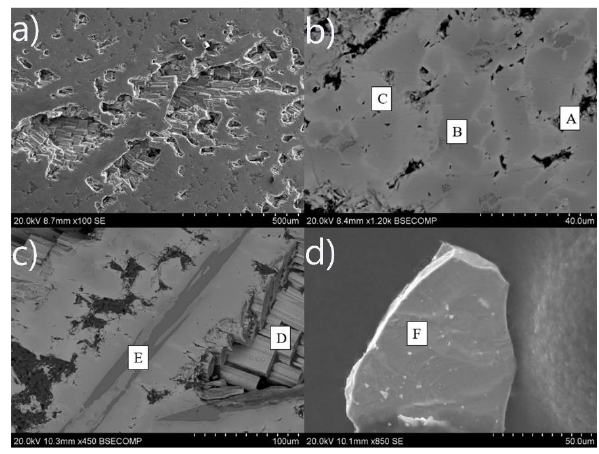
Figure 2. Scanning electron microscope (SEM) micrographs and energy dispersive X-ray spectroscopy (EDS) analysis of Al – Pd – Fe samples prepared by SPS. ( a – c ) reveal the as-cast state and ( d ) the fragment of measured single crystal. (a) and (d) were taken with secondary electron (SE), ( b ) and ( c ) were taken with back-scattered electron (BSE). EDS analysis was performed on different sites of the denoted regions A – F and results are listed in Table 1. Table 1. The chemical compositions of a piece of educts and a fragment of single crystal from the spark plasma sintering samples analyzed by the EDS (bold numbers indicate the mean values of different measured chemical compositions in the same region). Regions A – F are denoted in Figure 2.